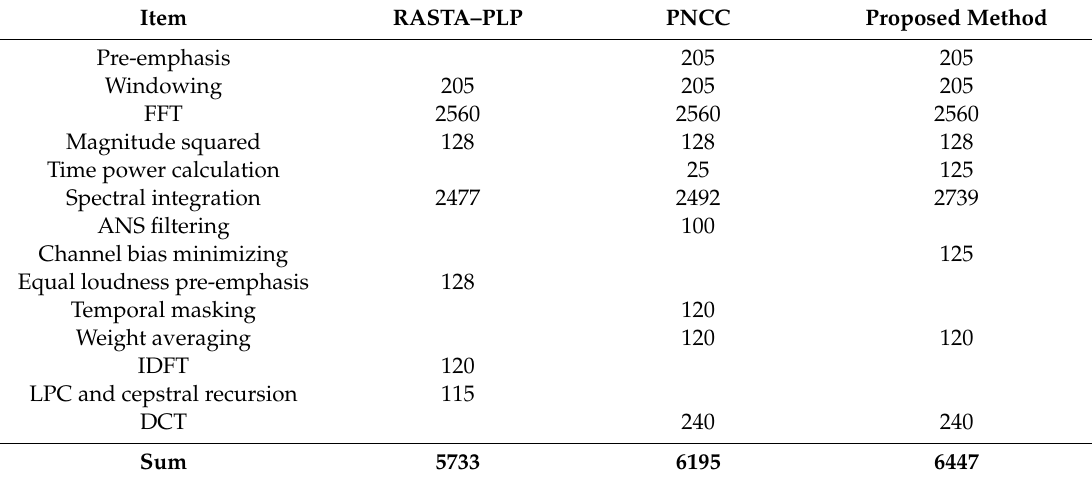
Table 1. Number of multiplications and divisions in each frame